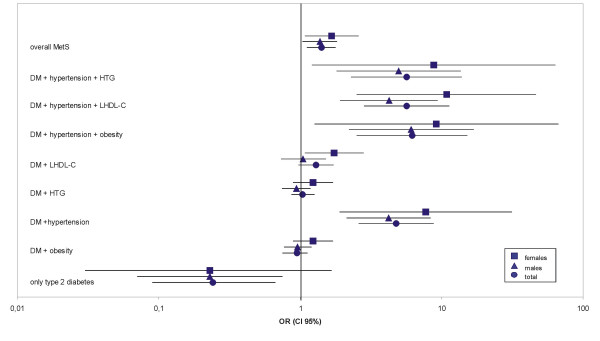
OR (95% CI) for AVD in the DIG population divided by sex. Data are presented for overall MetS, single traits and their combinations of the MetS. Only those combinations with associated AVD events are displayed. The scale of OR was log-transformed.